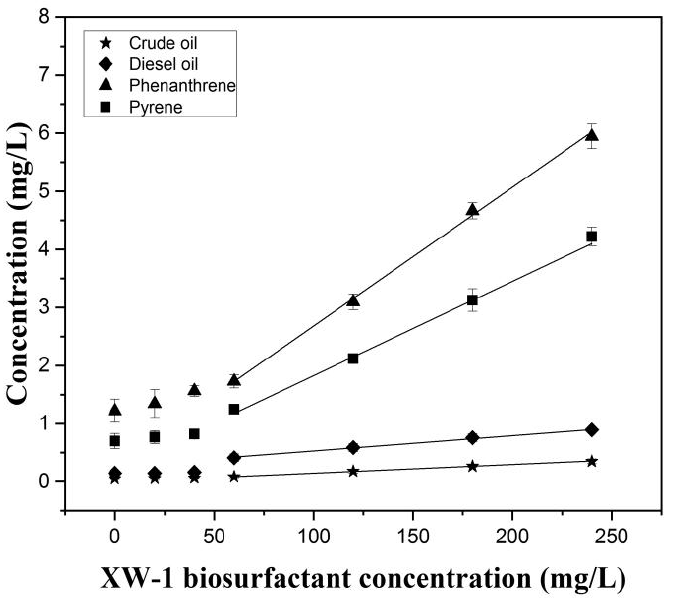
Figure 1. Effects of biosurfactant on the solubilization of Phen, Pyr, diesel oil and crude oil in aque- ous phase.